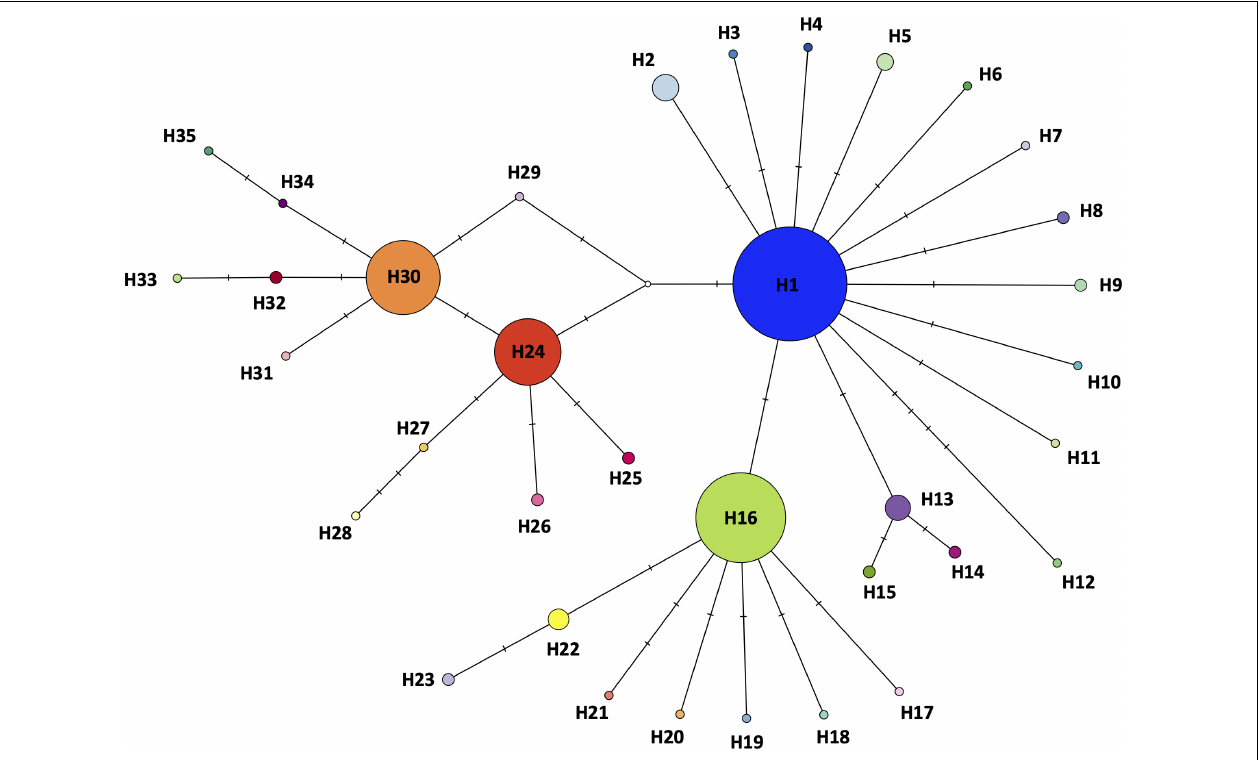
FIGURE 4 | Haplotype network based on concatenated mitochondrial 16S rRNA and COI genes sequences, generated by statistical parsimony. The area of the circles is proportional to the number of specimens sharing haplotype. Mutation steps between haplotypes are shown as hatch marks ( Supplementary Appendix 2 ).